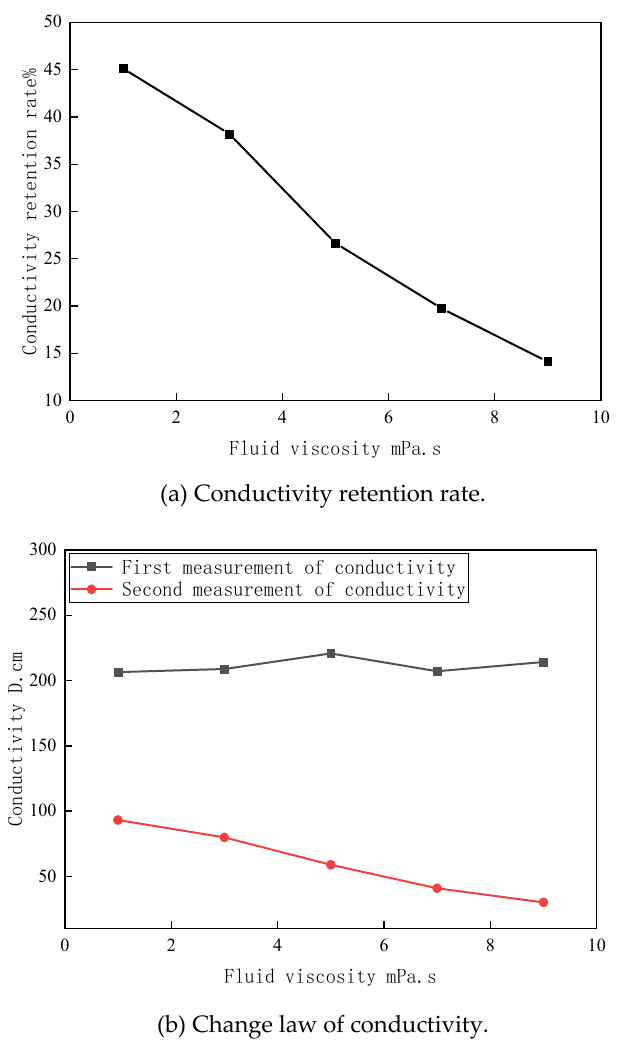
Figure 3. Influence of fracturing fluid viscosity on conductivity.